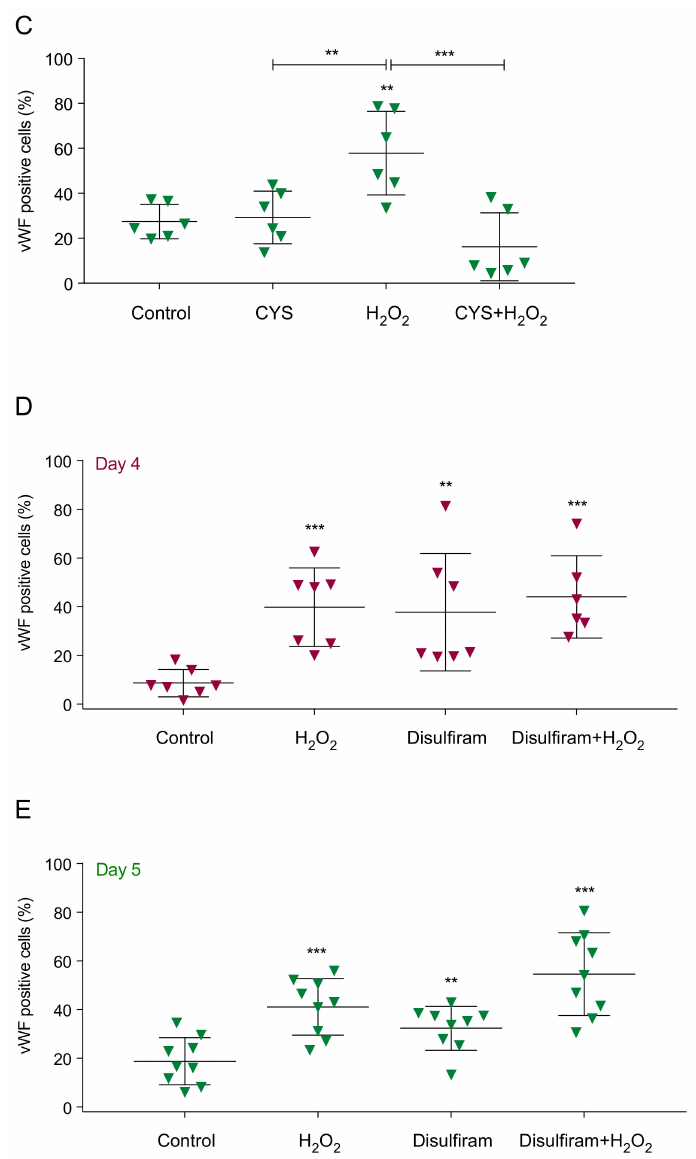
Figure 2. Monocyte-derived cells cultured in the presence of hydrogen peroxide (H 2 O 2 ) increase the expression of endothelial cell (EC) markers that is abolished by the presence of cysteine (Cys). ( A ) vWF levels in monocytes-derived cells maintained in CFU media (Day 4) plus 1 day in EBM-2 plus VEGF (Day 5), in the presence or absence of H 2 O 2 (15 µ M). ( B ) Immunofluorescence for CD31 (green), vWF (red), CD146 (green) and CD14 (red) in monocytes cultured during 5 days in EBM-2 medium with VEGF, in the presence or absence of H 2 O 2 (15 µ M). Nuclei are in blue (DAPI), magnification 400 × (bars 5 µ m). ( C ) vWF levels in monocytes-derived cells maintained in EBM-2 plus VEGF, in the presence and / or absence of Cys (0.4 mM) and H 2 O 2 (15 µ M) for 1 day. ( D / E ) vWF levels in monocytes-derived cells maintained in CFU media (Day 4) plus 1 day in EBM-2 plus VEGF (Day 5), in the presence or absence of H 2 O 2 (15 µ M) and / or disulfiram (2 µ M). Each dot represents a healthy donor. ** p ≤ 0.01 *** p ≤